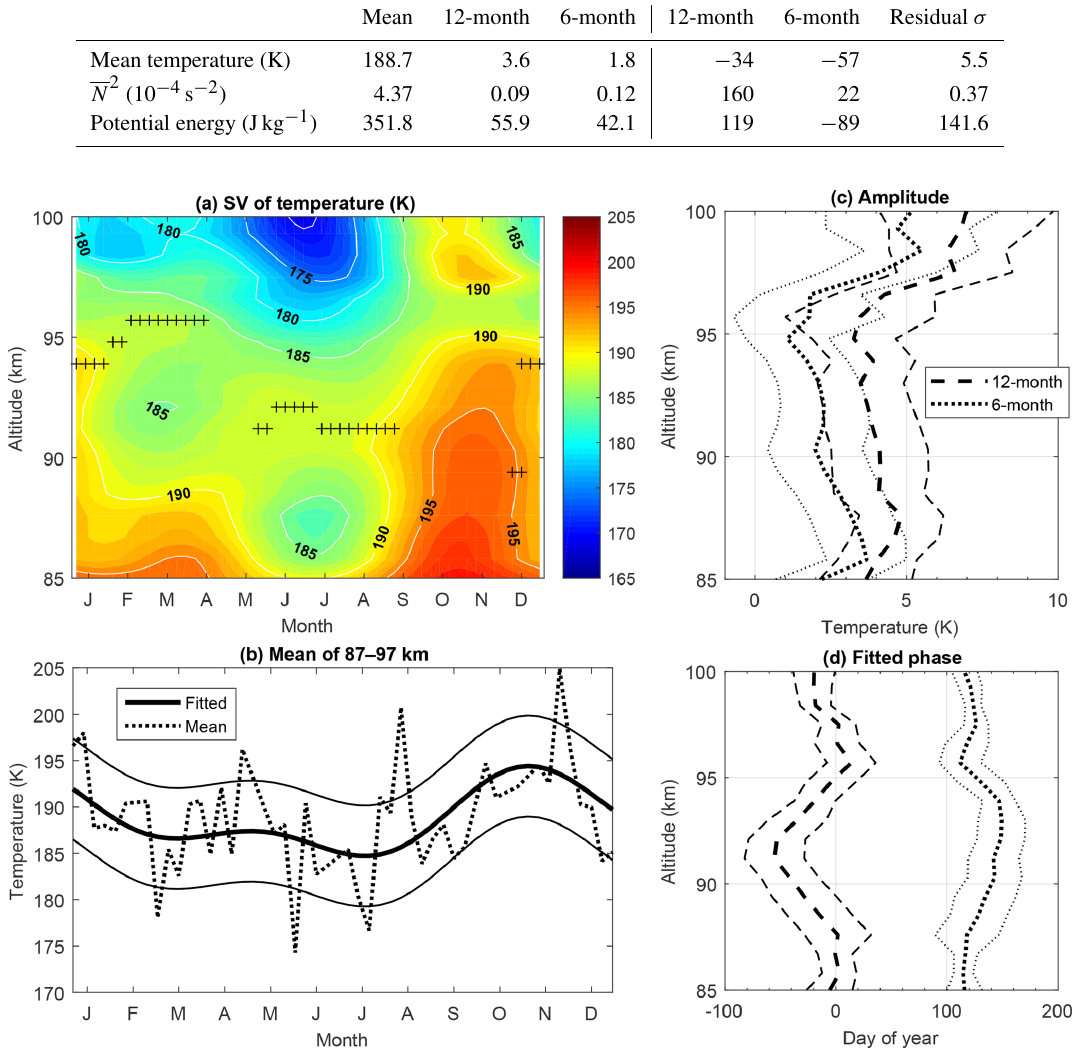
Figure 5. (a) Seasonal variations of the harmonic fitted nocturnal temperature plotted versus altitude and month, where the crosses represent the altitude of temperature inversion layer. (b) Observed (dotted curve) and harmonic fitted (thick solid curve) mean temperature between 87 and 97km, where the width between the thin solid curves and the thick solid curve is 1 standard deviation (1 σ ). (c) 12-month (dashed curve) and 6-month (dotted curve) amplitudes and their 1 σ deviations (thin lines). (d) 12-month (solid curve) and 6-month (dotted curve) phases and their 1 σ deviations (thin